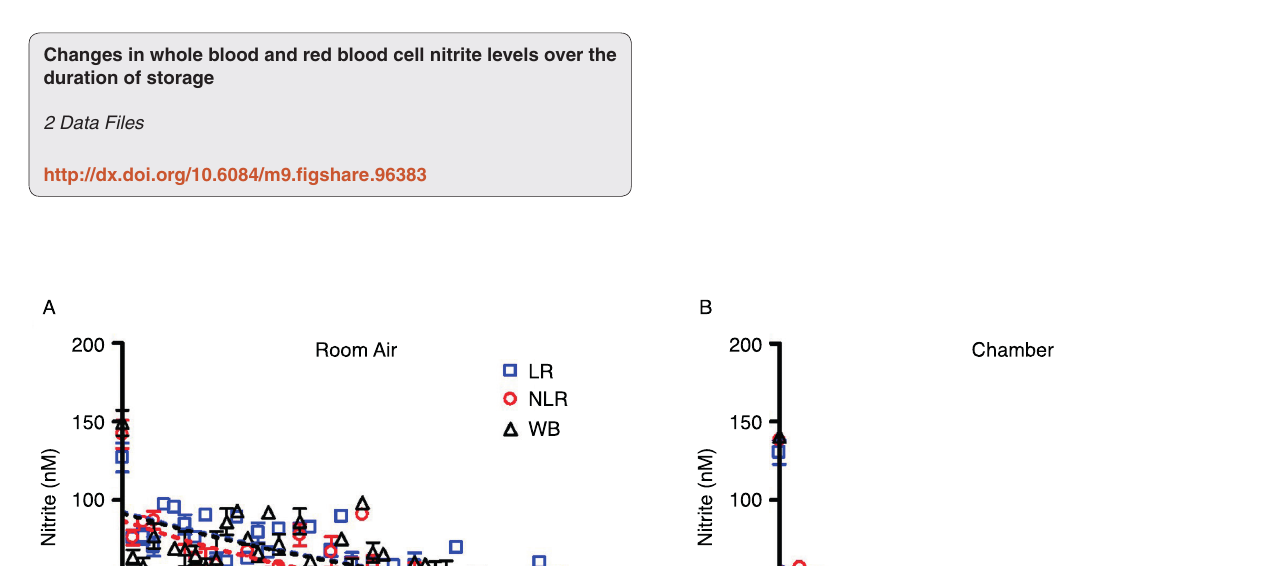
Figure 1. Whole blood (1A) and red blood cell (1B) nitrite decay over the first 5 hours following blood draw. Blood components were kept in room air at 24°C; number of donors, n=6 ( A ), n=4 ( B ). Time points above do not account for a 3–5 minute delay in receipt of blood from phlebotomist.